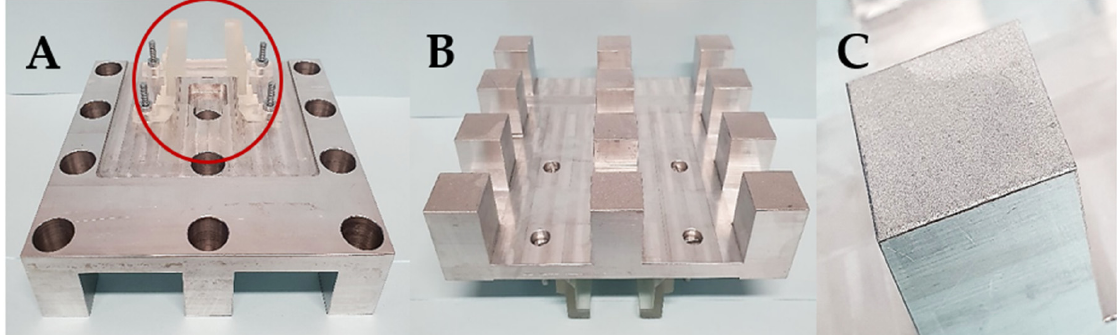
Figure 6. ( A ) Top and ( B ) bottom view of the aluminium 12 BP fabricated through CNC milling. The novel design includes hollow build-spots, thus reducing the weight of the platform. A 3D printed attachment (circled in red) allows firm attachment of the platform to the SLA apparatus. ( C ) Detail of bead-blasted surface of the aluminium 12 BP. Such a finish was selected to optimise the adhesion of objects during the 3D printing process and to facilitate their release at the end of the print.